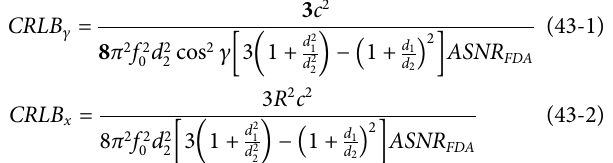
Frontiers in Physics |